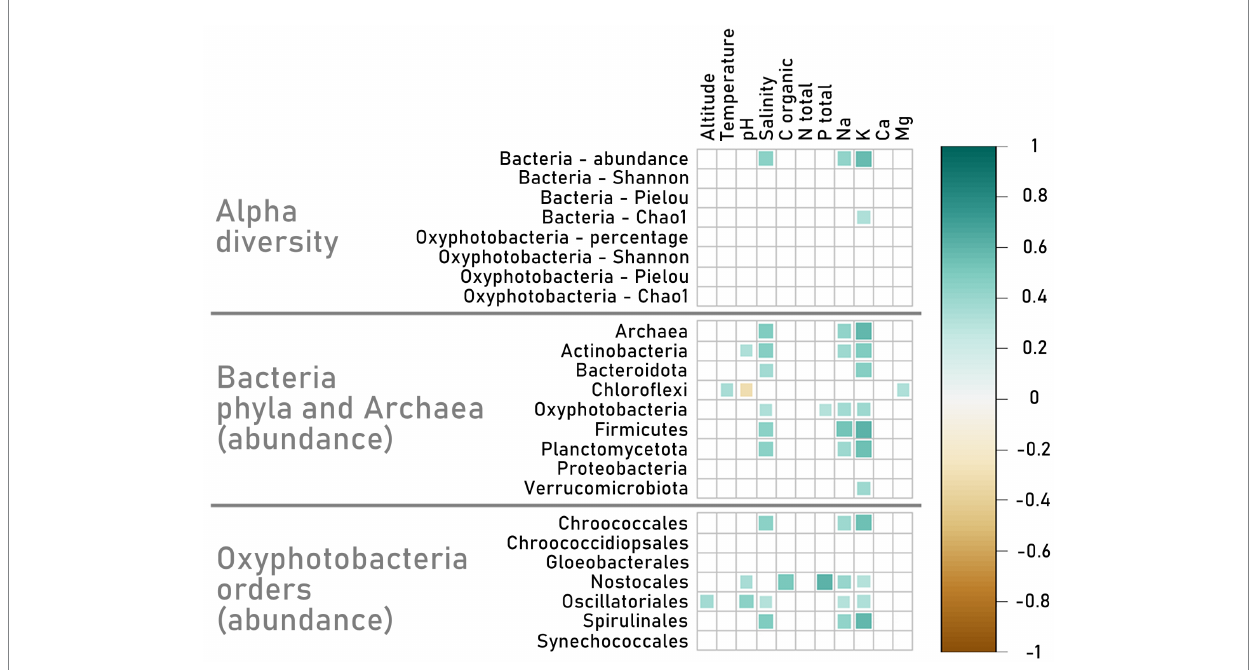
FIGURE 9 Matrix of Spearman’s rank correlations between environmental parameters (altitude, temperature, pH, salinity, total organic C, total N, total P, PO 43 − , NH 3+ , Na + , K + , Ca +2 , Mg +2 ) and alpha diversity (Shannon, Pielou and Chao1 indexes for Bacterial phyla and Oxyphotobacterial orders, as well as Bacterial abundance and Oxyphotobacterial percentage in samples) and abundance of Bacteria phyla, Archaea, and Oxyphotobacterial orders based on the number of reads on the ASV level. The graph is showing only statistically significant results ( p < 0.05). The Bacteria phyla used in this matrix are those whose abundance results in min. 1% of all Bacterial abundance. Nine samples were excluded because of the lack of a complete set of environmental